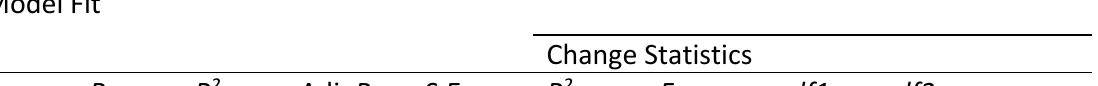
Multiple Regression Analysis Between Farmers’ Quality of Life, Farmer’s self-Leadership and Ability to Lead Others’ Competencies Domains Model Fit